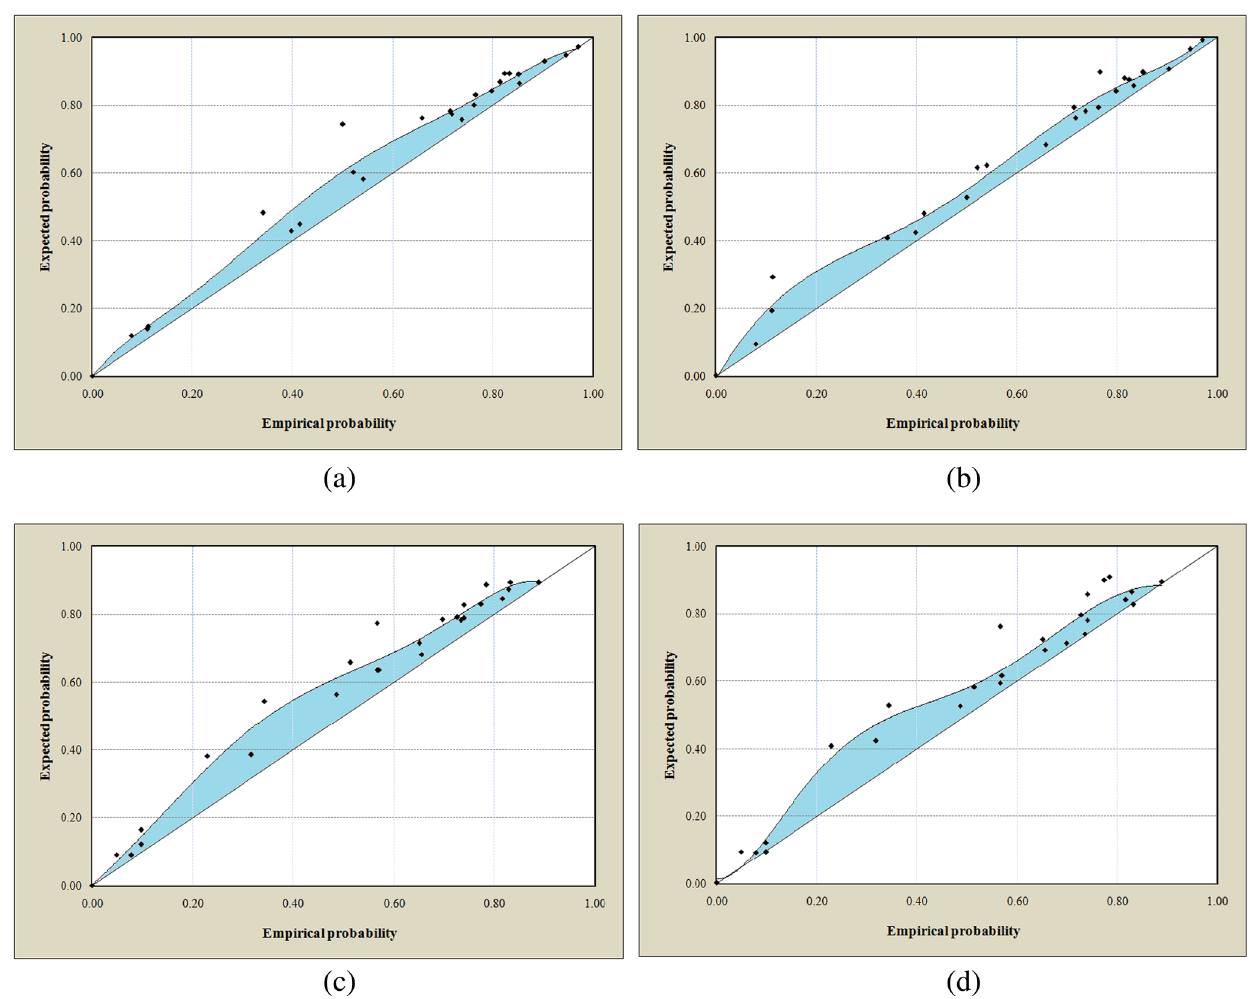
Fig. 6 Agreement between the probabilities of headways obtained from the ‘ nomograph ’ and field data obtained from a ‘ pilot study ’ : a West (nomograph) and North (pilot study) bound traffic; b West (nomograph)